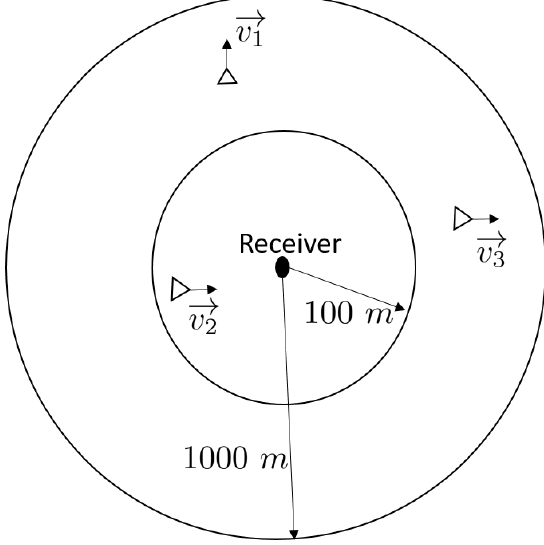
Figure 3. Scheme of the simulated